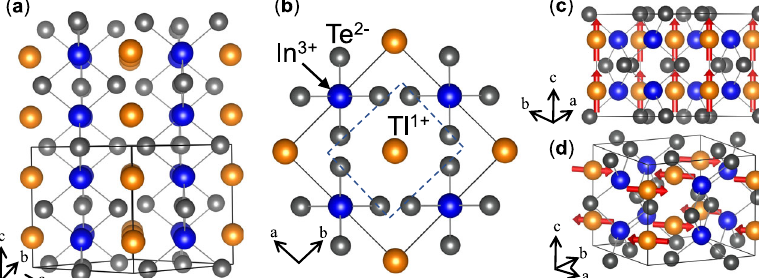
Fig. 1 Crystal structure, bonding, and rattling vibrations. a Chain-like crystal structure of TlInTe 2 , where In 3 + cations (blue sphere) are tetrahedrally coordinated by Te 2 − anions (dark gray sphere), forming InTe 4 tetrahedron. These InTe 4 tetrahedra share their edges, and extend along the c-axis, giving rise to a chain-like structure. Tl 1 + cations (orange sphere) occupy the spaces between the chains and stabilize the structure through electron transfer from Tl 1 + to the [InTe 2 ] 1 − sublattices. The conventional unit cell is outlined by the solid black line. b A top- down view of the crystal structure, where it can be seen that Tl atom occupies the empty space inside the square anti-prismatic (outlined by dashed blue line) environment formed by eight Te atoms. Visualization of the c longitudinal ( R LO ) and d transverse ( R TO ) optical rattling ( R ) phonon modes at the X point in the Brillouin zone, where the atomic displacements are indicated by the red arrows.